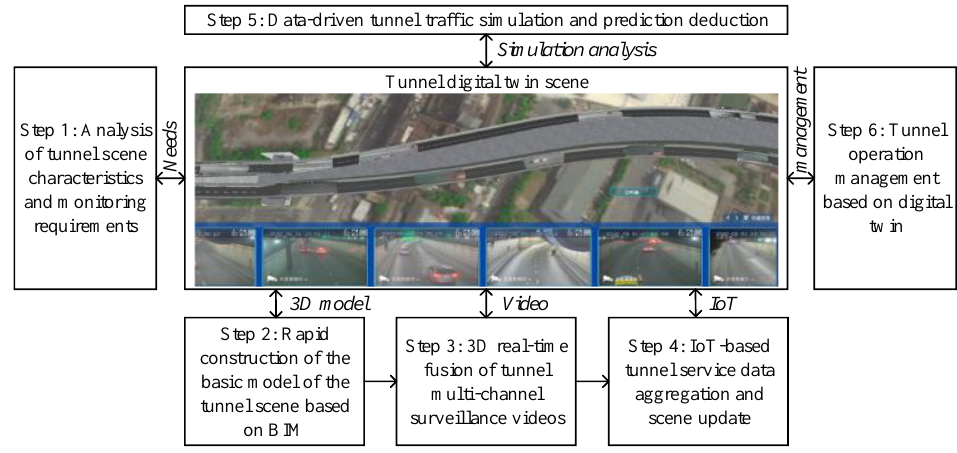
Figure 2. Method followed in this